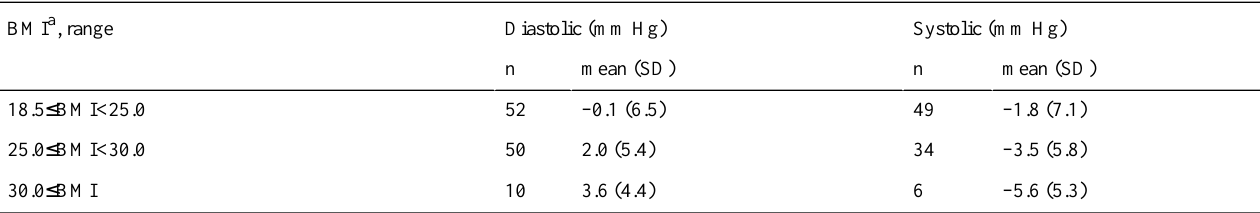
Table 2. Error in blood pressure estimation for this cohort stratified by body mass index at the time of calibration (no subjects in this cohort had a body mass index lower than 18.5 kg/m 2